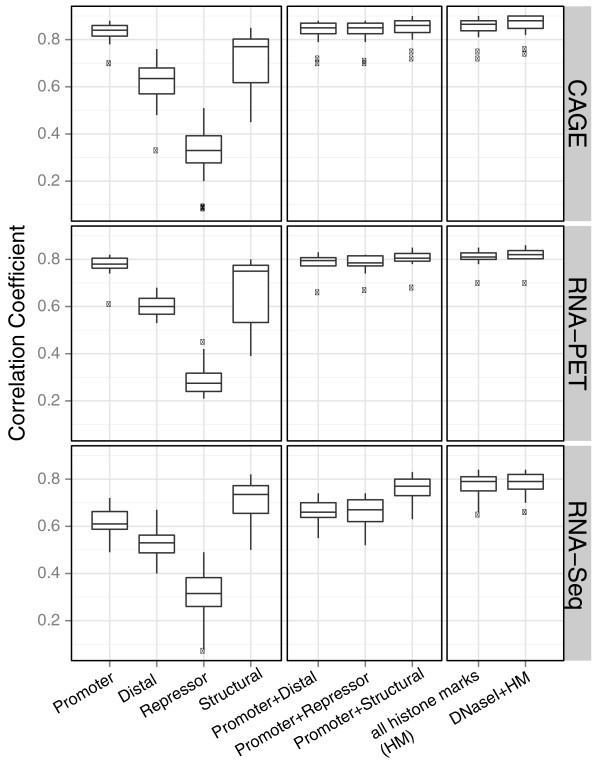
Comparison of groups of chromatin features. Twelve chromatin features are grouped into four categories according to their known function in gene regulation: promoter marks (H3K4me2, H3K4me3, H2A.Z, H3K9ac, and H3K27ac), structural marks (H3K36me3 and H3K79me2), repressor marks (H3K27me3 and H3K9me3), and distal/other marks (H3K4me1, H4K20me1, and H3K9me1). Correlation coefficients are shown for individual categories, a combination of promoter with three other categories, all histone marks (HM), and HM together with DNase I hypersensitivity are shown in the boxplot for CAGE (TSS-based), RNA-PET (TSS-based), and RNA-Seq (Tx-based) expression data. It indicates that for TSS-based data, promoter marks are the most predictive among the four categories, while for Tx-based expression, structural marks are the most predictive.